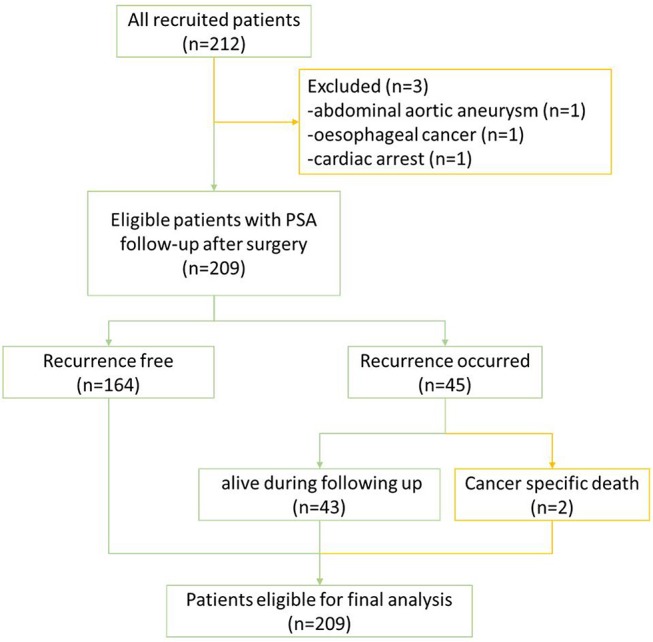
Flowchart of study.